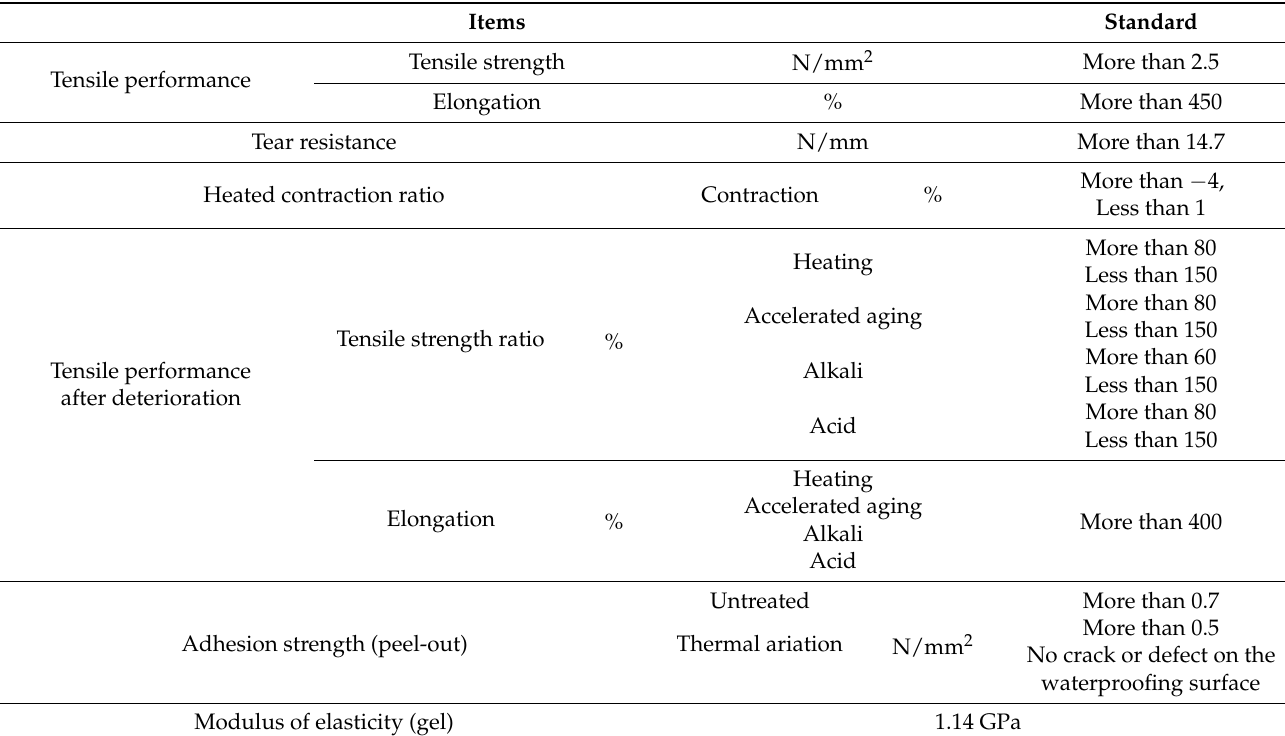
Table 3. Composite asphalt sheet (CAS) specification.